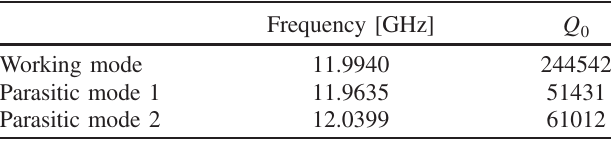
TABLE IV. Modes of the storage cavity.